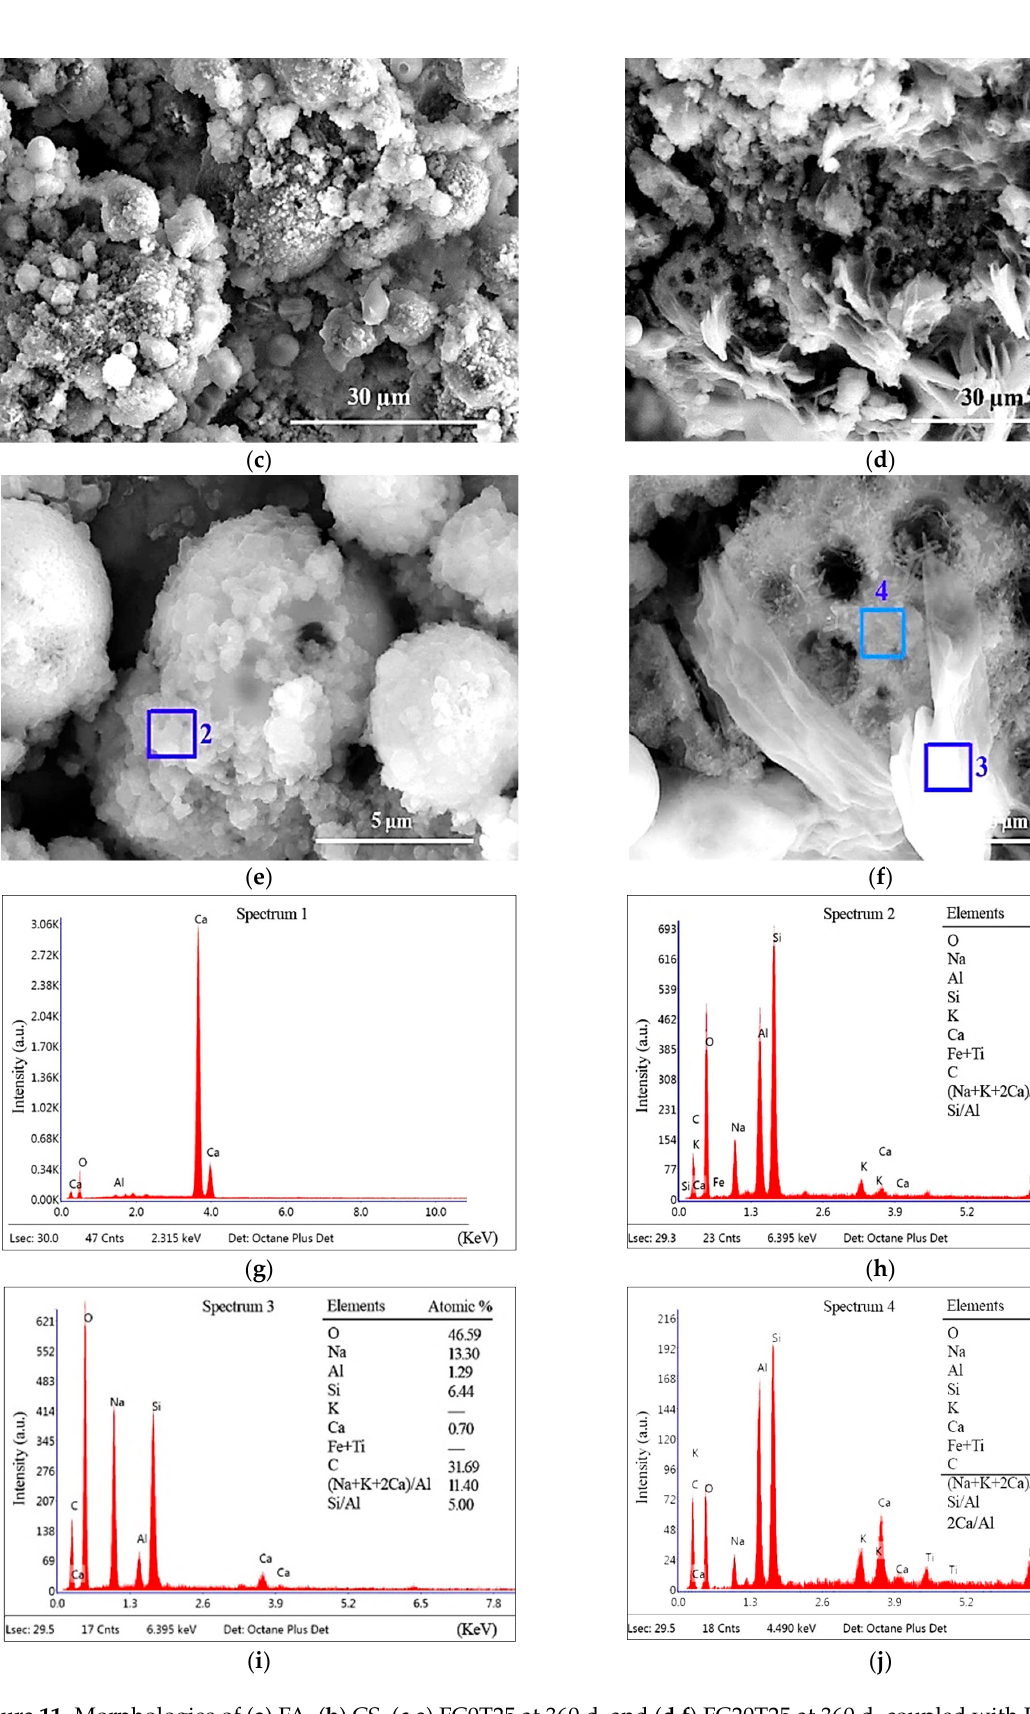
Figure 11. Morphologies of ( a ) FA, ( b ) CS, ( c , e ) FC0T25 at 360 d, and ( d , f ) FC20T25 at 360 d, coupled with EDS spectra of the representative points ( g ) spectrum 1, ( h ) spectrum 2, ( i ) spectrum 3, and ( j ) spectrum